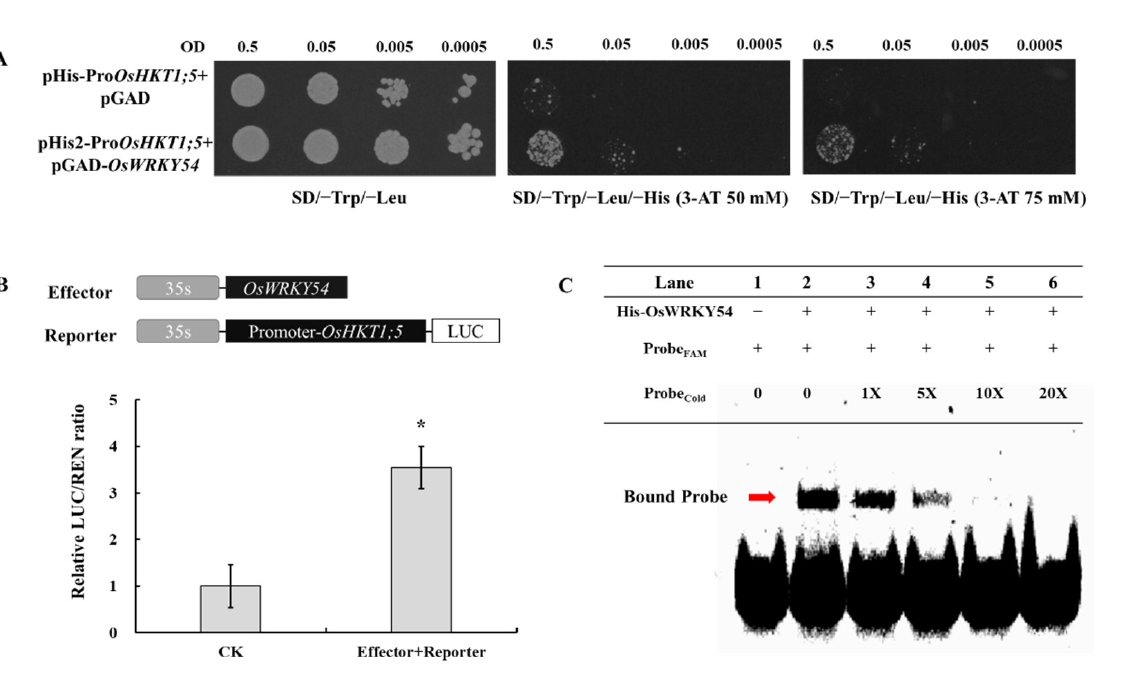
Figure 8. Interaction of OsWRKY54 with the promoter of OsHTK1;5 . ( A ) OsWRKY54 binding to the OsHKT1;5 promoters in yeast. Different pairs of plasmids (pGAD-OsWRKY54 and pHIS2- ProOsHKT1;5 , or control pGADT7 and pHIS2) were transformed into yeast cells. Transformed cells were spotted on SD medium containing 0, 50, or 75 mM 3-amino-1,2,4-triazole at 30 °C for 3 days without His. ( B ) Activation of the OsHKT1;5 promoters by OsWRKY54 in rice protoplast. ProOsHKT1;5:LUC and 35S:OsWRKY54 were co-introduced into rice protoplast. The activity of REN gene was used as internal control. The relative ratio of LUC/REN is shown as mean ± SD (n = 3), * p < 0.05. ( C ) EMSA showing the binding of His-OsWRKY54 to the W-box element in the OsHKT1;5 promoter. FAM-labeled probe (FAM) was shown in lanes 1–6. An unlabeled probe (Cold) was used in 0-, 1-, 5-, 10-, or 20-fold molar excess (lanes 2–6). To further verify if OsWRKY54 had the ability to bind to the OsHKT1;5 promoter, we conducted a yeast one-hybrid (Y1H) assay. A 2.0 kb promoter fragment of OsHKT1;5 was fused with the HIS3 reporter gene, generating the pHIS- ProOsHKT1;5 construct. Yeast cells containing pHIS- ProOsHKT1;5 plus pGADT7- OsWRKY54 grew better on these selective media than those containing pHIS- ProOsHKT1;5 and the empty vector pGADT7 (Figure 8A), suggesting that OsWRKY54 could directly bind to the OsHKT1;5